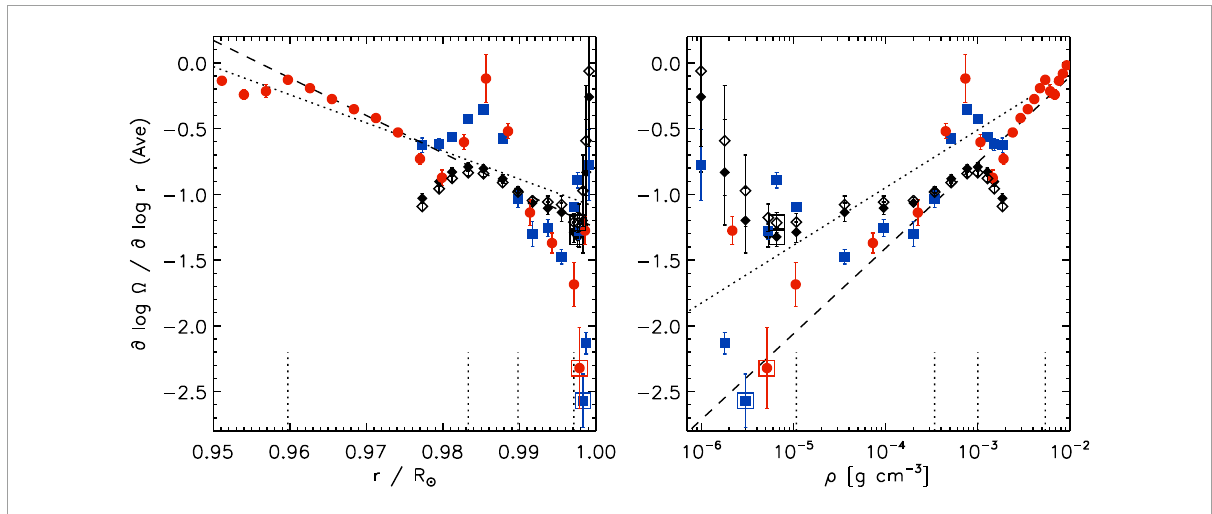
FIGURE 4 The radial gradient of the solar rotation rate as a function of radius (left) and density (right) averaged over ± 45 . 0° latitude using 15°-tile RDA (black diamonds: GONG, blue squares: HMI) and 30°-tile RDA (red circles: HMI) covering Solar Cycle 24. The GONG values averaged over Solar Cycle 23 are included for comparison (open diamonds). Open squares indicate the location of the steepest gradient for each data set. The dashed line in the left panel is a linear regression over .960 R ⊙ to .975 R ⊙ , while the other lines are the same as in Figure 1 . The short vertical dotted lines indicate four depths (.960 R ⊙ , .983 R ⊙ , .990 R ⊙ , and .997 R ⊙ ). Compare with Figures 1 , 2 .